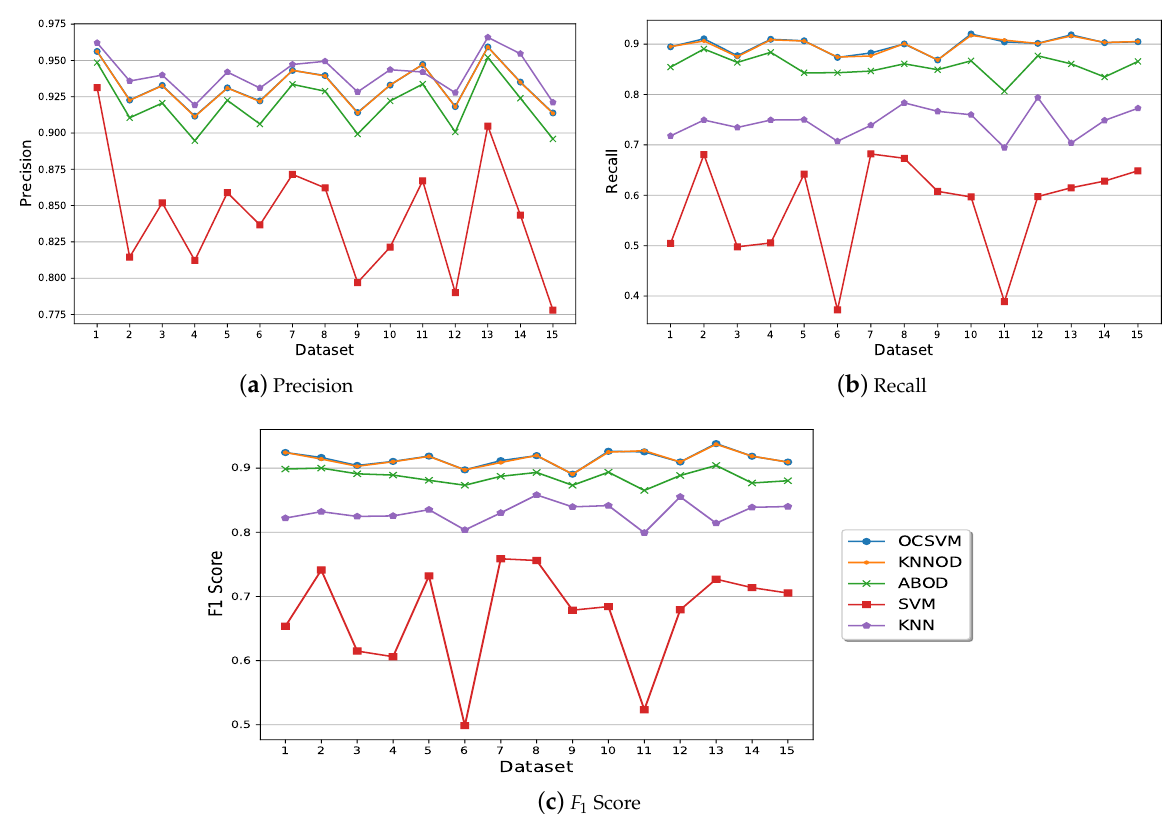
Figure 15. Performance comparison of the semi-supervised algorithms with supervised algorithms in terms of average precision, recall, and F 1